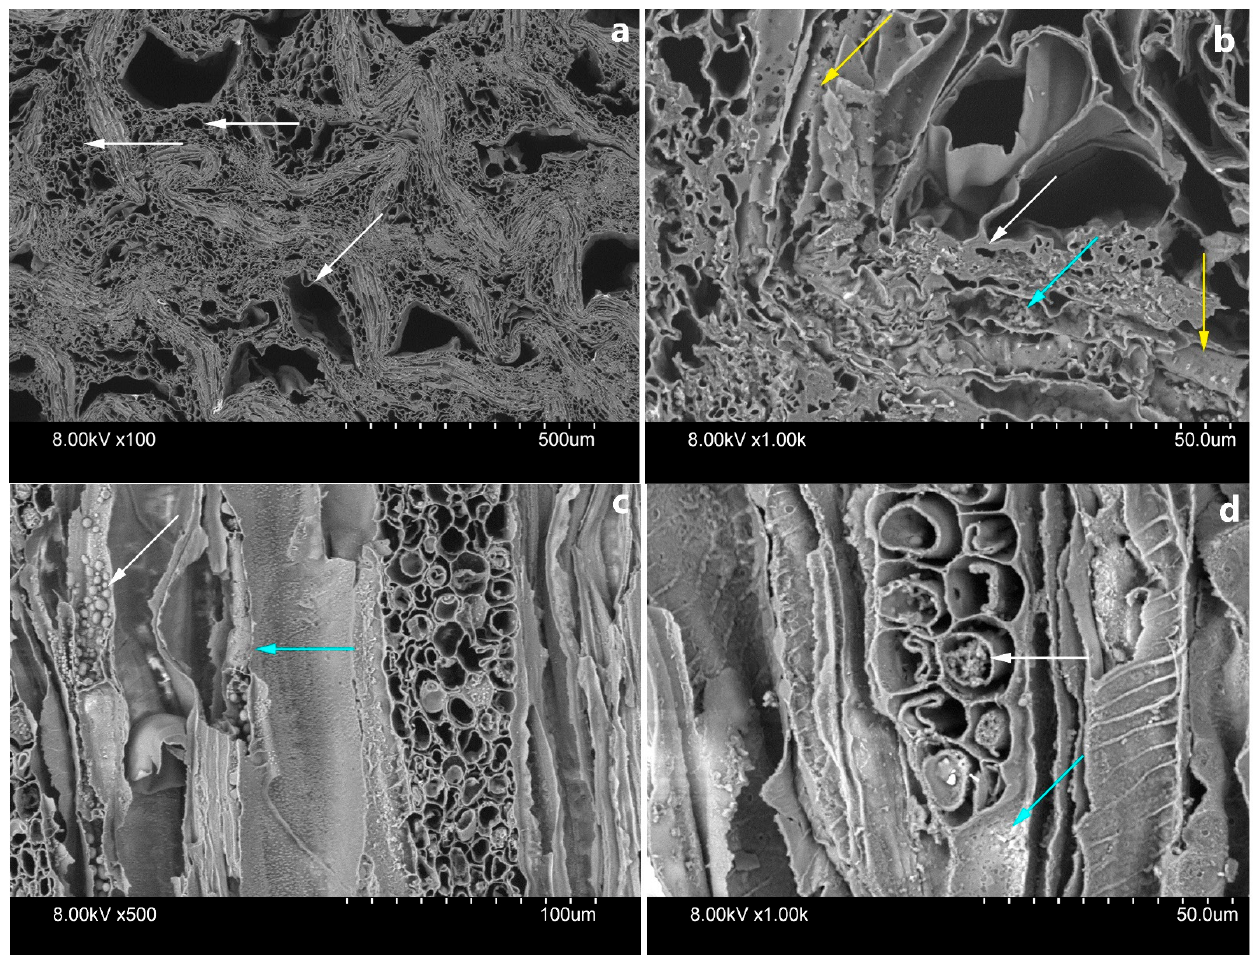
Figure 5. Scanning electron microscopy (SEM) micrographs from cross-sections ( a , b ) and tangential section ( c , d ) of archaeological elm. Arrows indicate the damaged parts of archaeological wood samples.